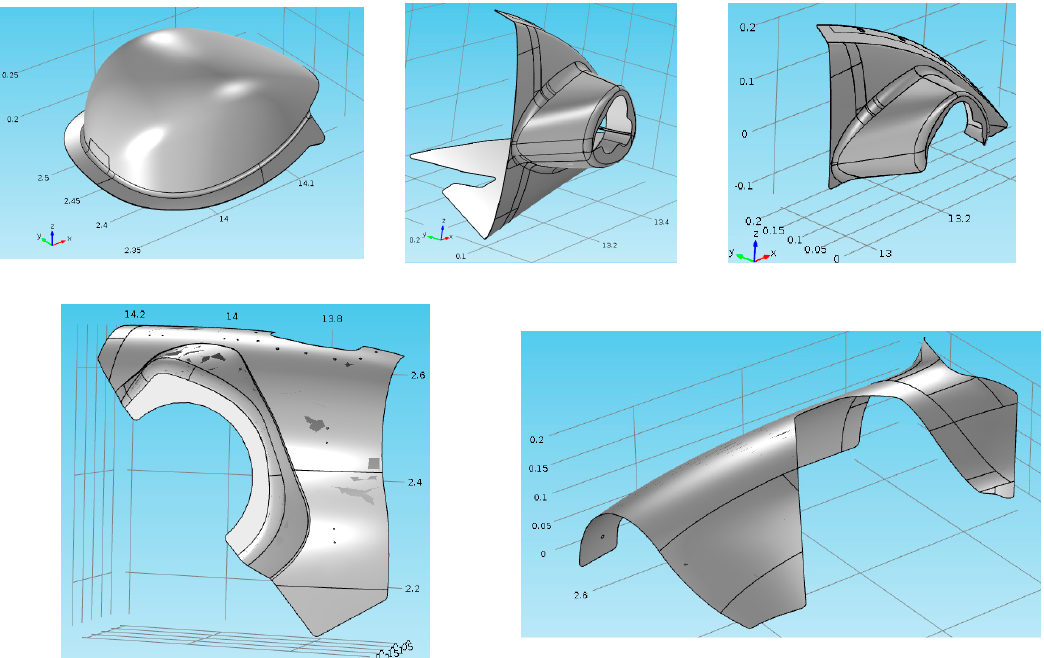
Figure 12. A group of the composite rotorcraft cowlings intended for manufacture by vacuum infusion technology.